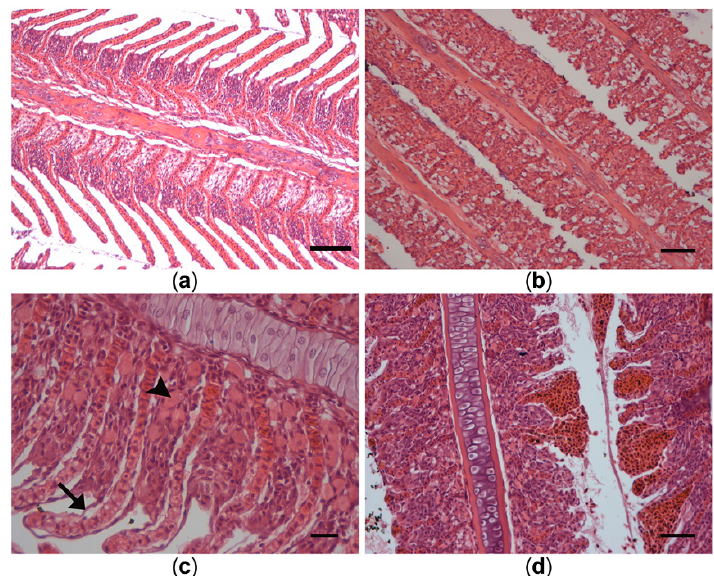
Figure 6. Histopathological alterations in the gills of Prussian carp Carassius gibelio from Lake Ludoš, 2018: ( a ) control fish; ( b ) fusion of the secondary lamellae; ( c ) intensive proliferations of chloride cells (arrowhead) and oedema (arrow); ( d ) telangiectasia. H&E staining. A and D–50 µ m; B–100 µ m; C–20 µ m.